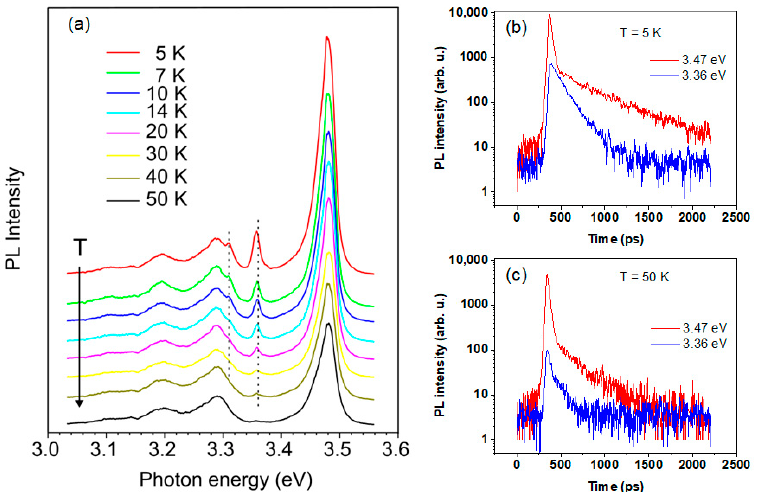
Figure 4. ( a ) Thermal evolution of PL spectra measured at an excitation power of 5 mW for hybrid Ag NPs/GaN NW structure. Spectra are shifted vertically for clarity. The dashed lines are a guide for the eye. PL decay curves at 5 K ( b ) and 50 K ( c ) for the hybrid Ag NPs/GaN NW structure measured at the DBE peak at 3.47 eV (red line) and at the 3.36 eV feature (blue line).